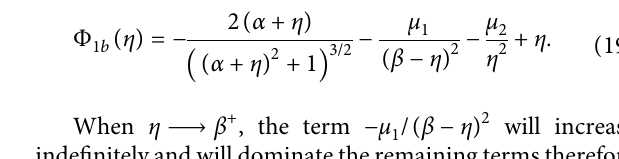
when μ � 3 (a) C � − 5 . 6, (b) C � − 5 . 65, (c) C � − 7 . 05, (d) C � − 7 . 5